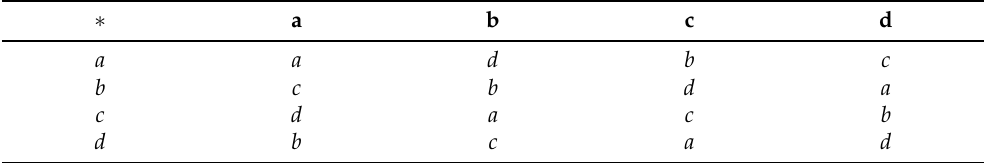
Table 2. L1-transposition regular